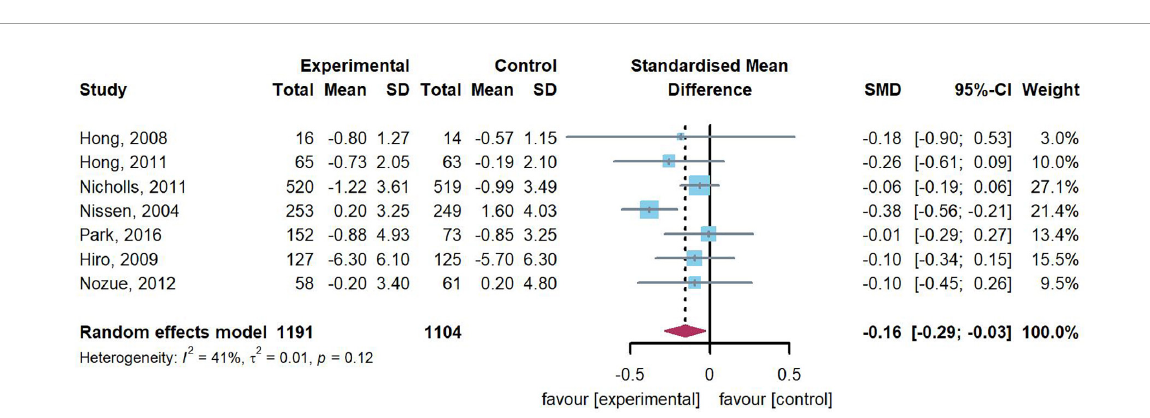
( p = 0.024). The regression coefficient of this